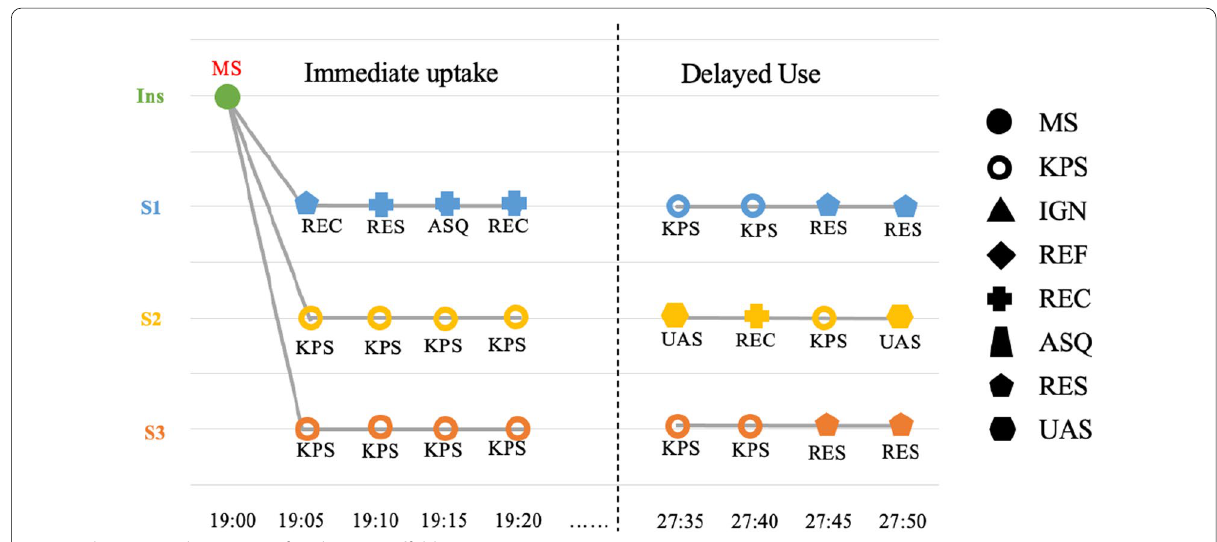
Fig. 8 The temporal transition after the MS